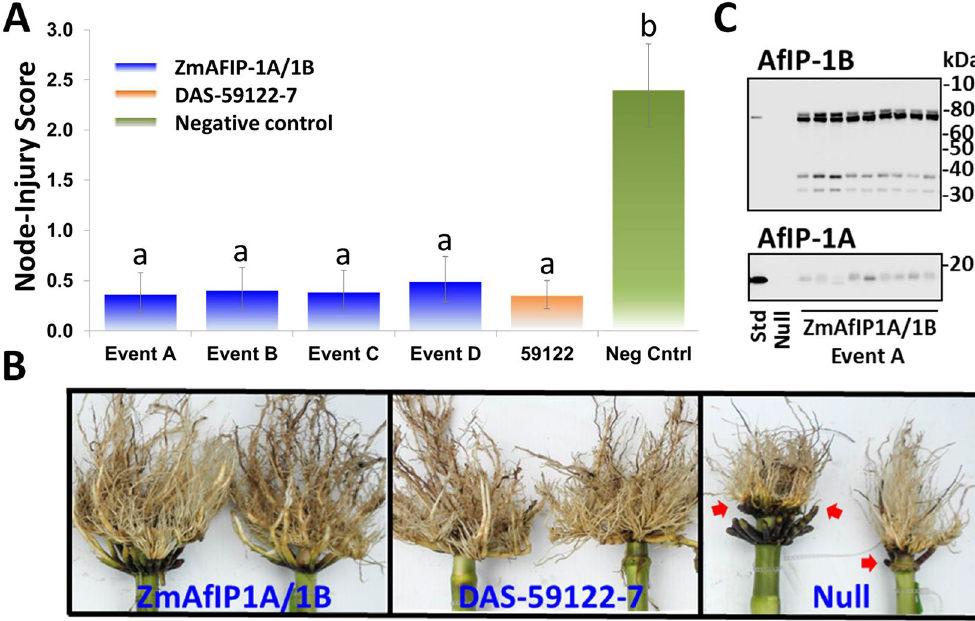
Figure 1. Protection of T2 generation transgenic maize accumulating AfIP-1A/1B in field tests against WCR. ( A ) Comparison of node-injury scores (root ratings) among treatments across three field locations with high corn rootworm pressure in 2012. Injury from corn rootworm larval feeding was visually assessed using the Iowa State 0–3 Node-Injury Scale 20 . Estimated node-injury ratings followed by the same letter were not significantly different. A difference was considered statistically significant if the p -value of the difference was less than 0.05. ( B ) Root protection of a subset of the AfIP-1A/1B plants showing efficacy similar to the commercial DAS- 59122-7 control while the non-transgenic negative control reveals significant feeding injury (red arrows). ( C ) Western analysis of AfIP-1A and AfIP-1B accumulation in roots of nine siblings from Event